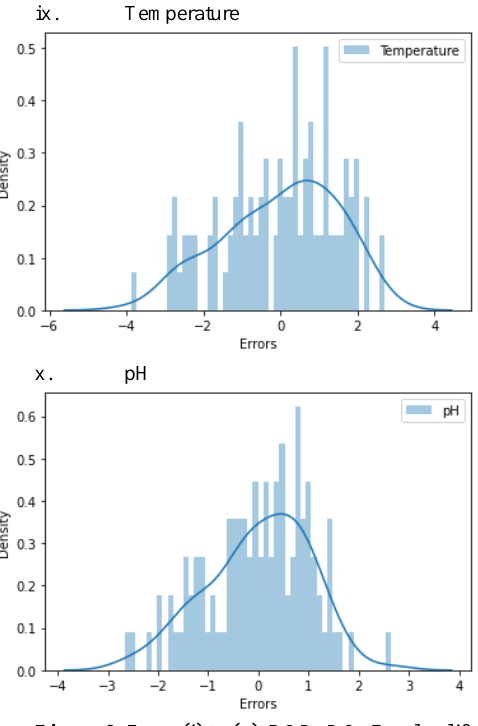
Figure 6 . From (i) to (x): BOD, DO, Fecal coliform, Chloride, TSS, Nitrate, Phosphate, Color, Temperature, pH: Shows the hisogram of residuals per model Figure 6 describes the distribution of the residuals through a histogram. The Shapiro-Wilk test which is a reliable test of normality was applied to each model and yielded the following results: Model Statistics